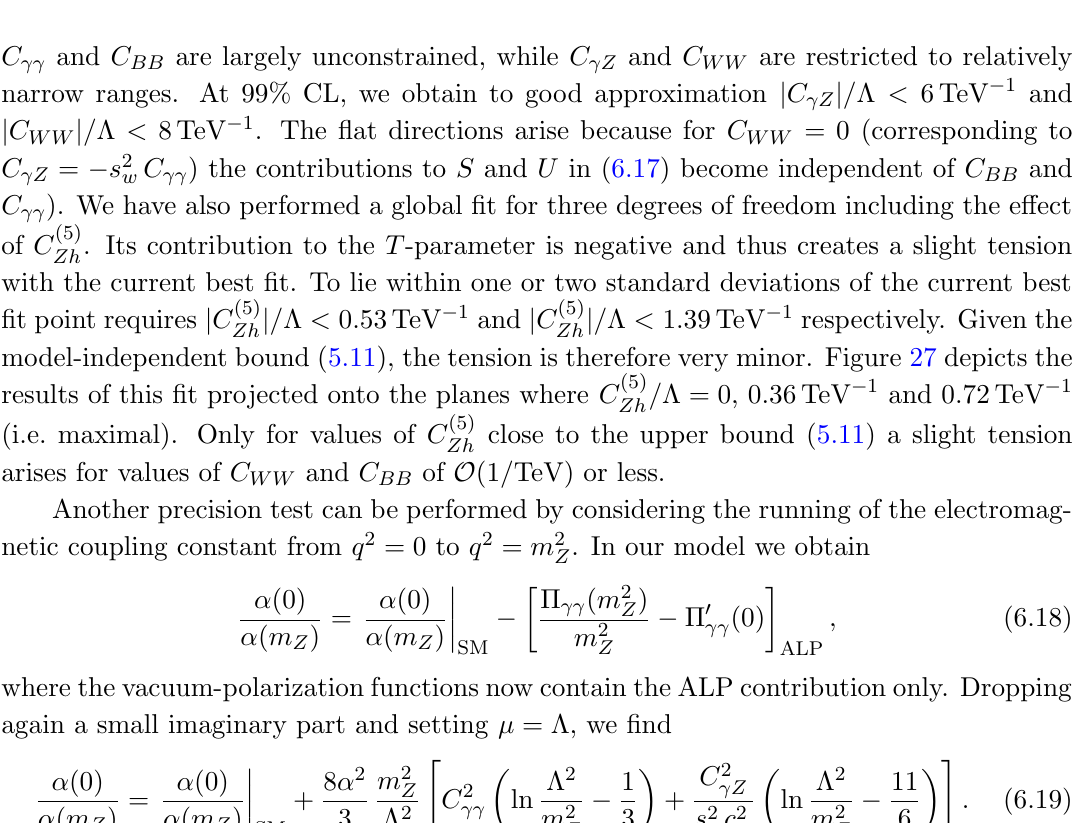
WW (cid:0) C BB obtained = (cid:3) = 0 (left), 0 : 36 TeV (cid:0) 1 Zh